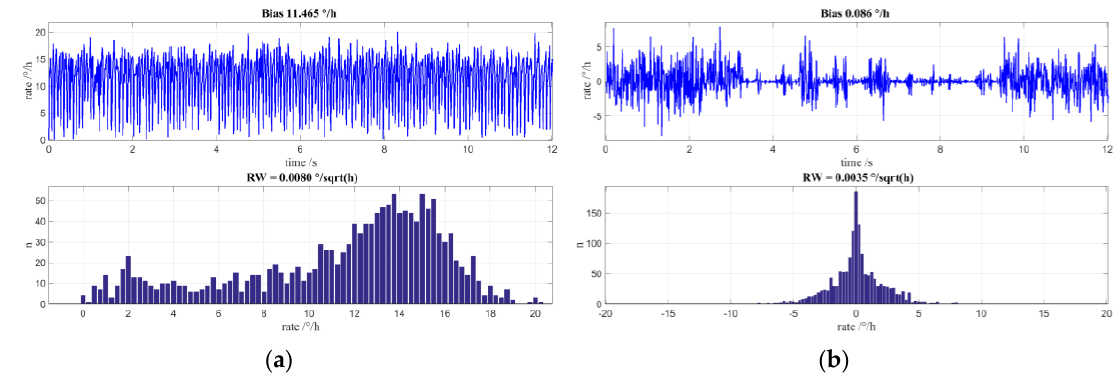
Figure 9. ( a ) Measured time signal and value distribution histogram for low applied rotation rate of approximately 12°/h; ( b ) Measured time signal and value distribution histogram for special case of applied rotation rate of 0°/h.